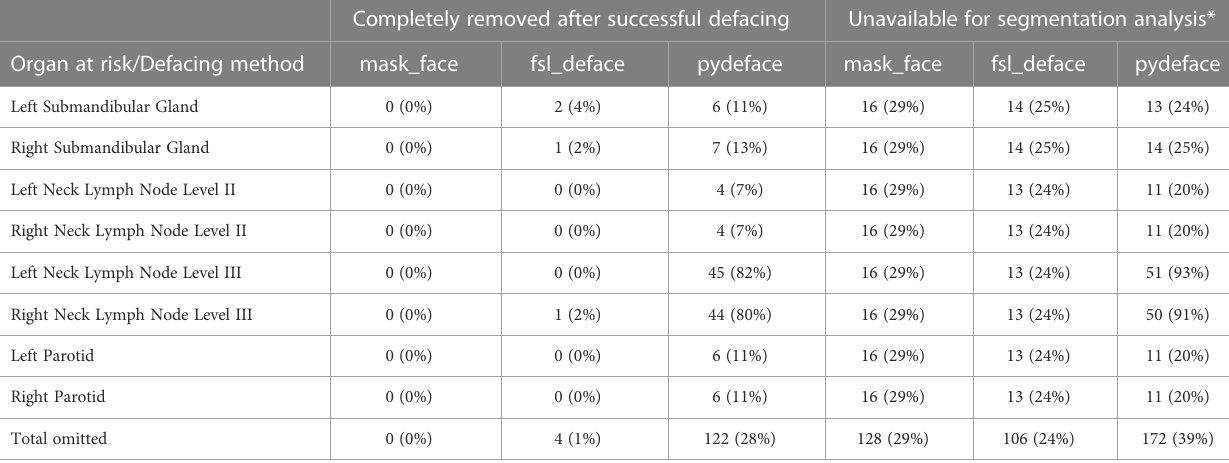
TABLE 1 Quantitative details on the number of organs at risk available after the defacing was applied for all 55 patient